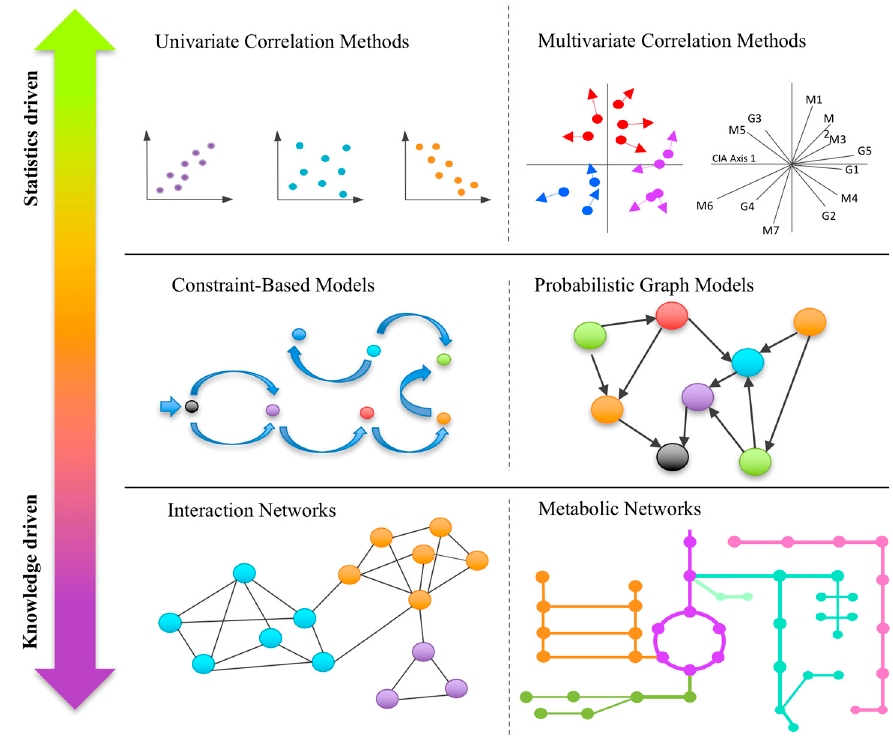
Figure 1. A graphical summary of the major types of computational approaches for integrative analysis of multi-omics data. These methods range from purely statistical approaches ( top ) to primarily knowledge-driven approaches ( bottom ). Integrating these two approaches may offer great potential for future development in the field.